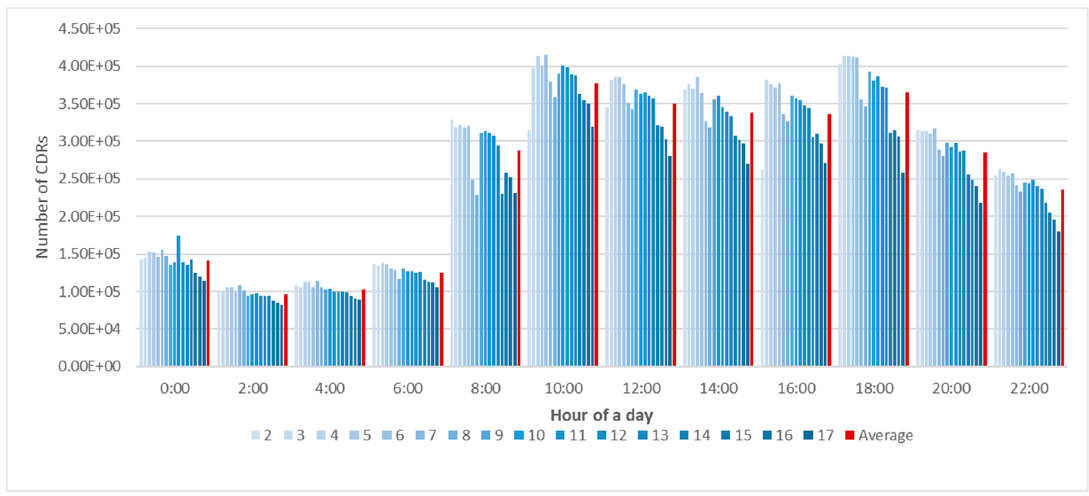
Figure 3. Variation in the number of CDRs for the first 30 s every 2 h over 16 days (2–17 February).